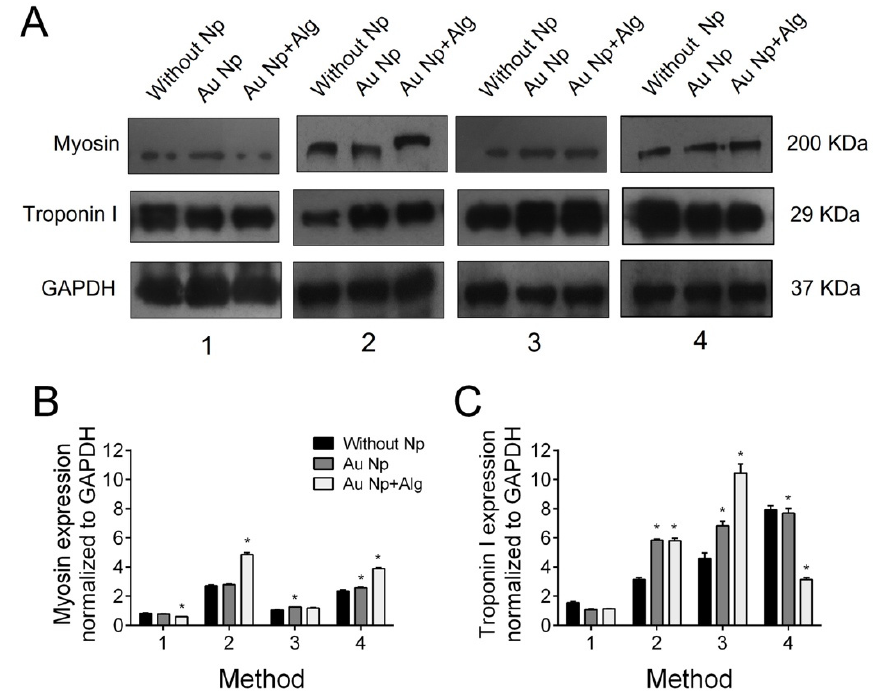
Figure 9. ( A ) Representative Western blot figure of myosin and troponin I in the different constructs: without AuNp and with AuNp and AuNp+Alg. Graphical representation of the quantitative analysis of ( B ) myosin and ( C ) troponin I expression. (*) p < 0.001. Data are presented as mean ± SE.